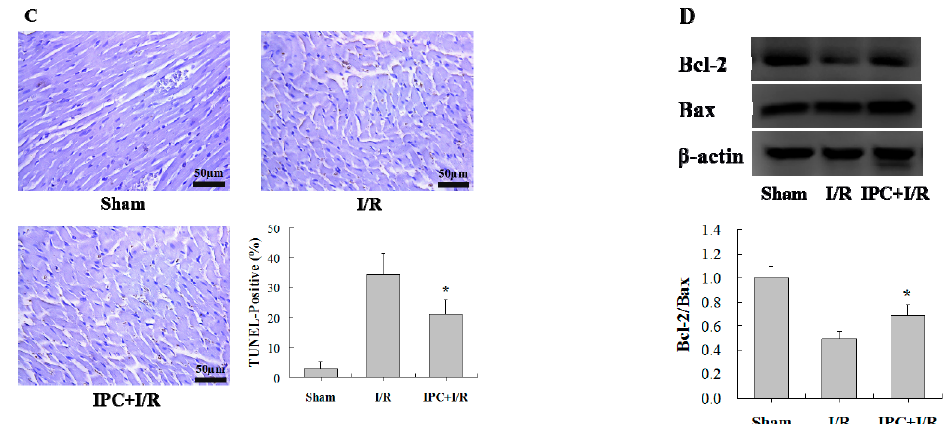
Figure 1. Ischemic preconditioning (IPC) treatment decreased myocardial ischemia/reperfusion (I/R) injury in vivo . ( A ) Representative photographs of Evans blue-TTC double staining and the quantitative analysis of myocardial infarct size between I/R (30-min ischemia/3-hour reperfusion) and IPC (three cycles of 5-min Ischemia/5-min Reperfusion)+I/R groups; ( B ) Hematoxylin and eosin (HE) staining of three groups, showing IPC mediated alleviation of the myocardium destruction; ( C ) Positive nuclear staining for myocardial apoptosis as assessed by the terminal deoxynucleotidyl transferase-mediated dUTP nick end labeling (TUNEL) assay and the quantitative analysis of apoptotic nuclei/total nuclei; ( D ) Analysis of Bcl-2 and Bax protein expression by western blotting and the corresponding quantitative analysis. β -actin was used as the loading control. n = 6. * p < 0.05 compared with I/R group.